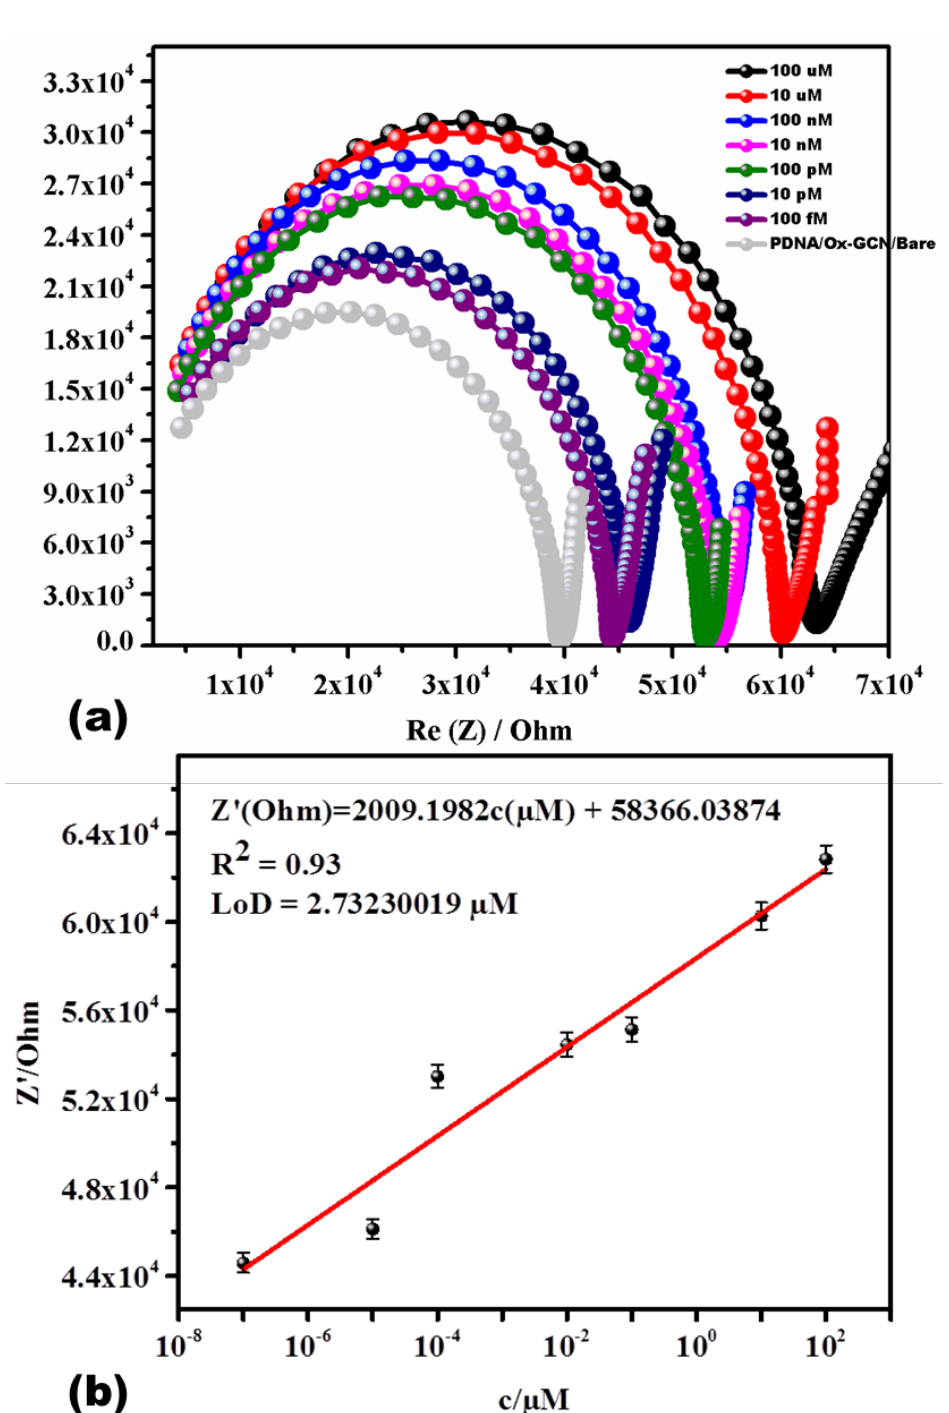
Figure 3. ( a ) Nyquist plot confirmed hybridization of different concentrations of the complimentary target DNA at PDNA / Ox-g-C 3 N 4 nanosheets / Bare using '0.1 mM KCl containing 0.1 mM MB (pH 7.2). ( b ) The calibration plot of the TDNA / PDNA / Ox-g-C 3 N 4 nanosheets / Bare electrode as a function of the logarithmic concentration of the Target DNA and change in resistance charge transfer.